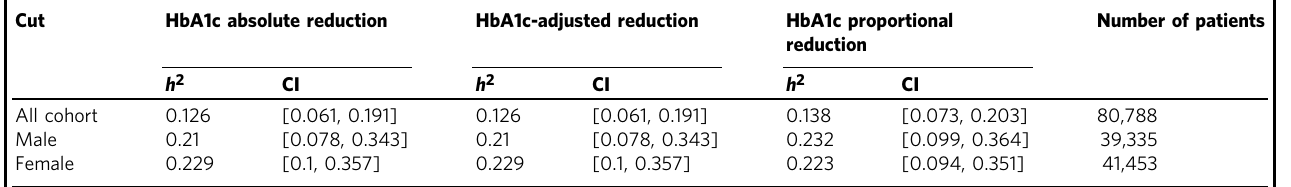
Table 4 Heritability estimates of metformin